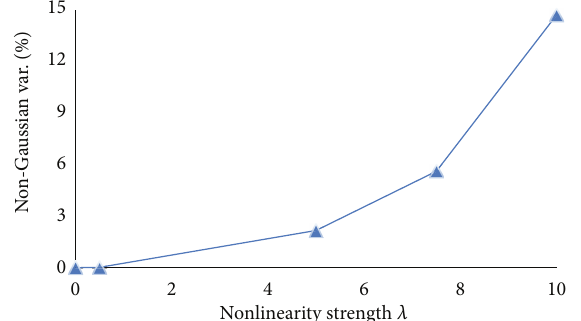
Figure 8: The percentage of the non-Gaussian variance to the total variance with the nonlinearity strength 𝜆 .